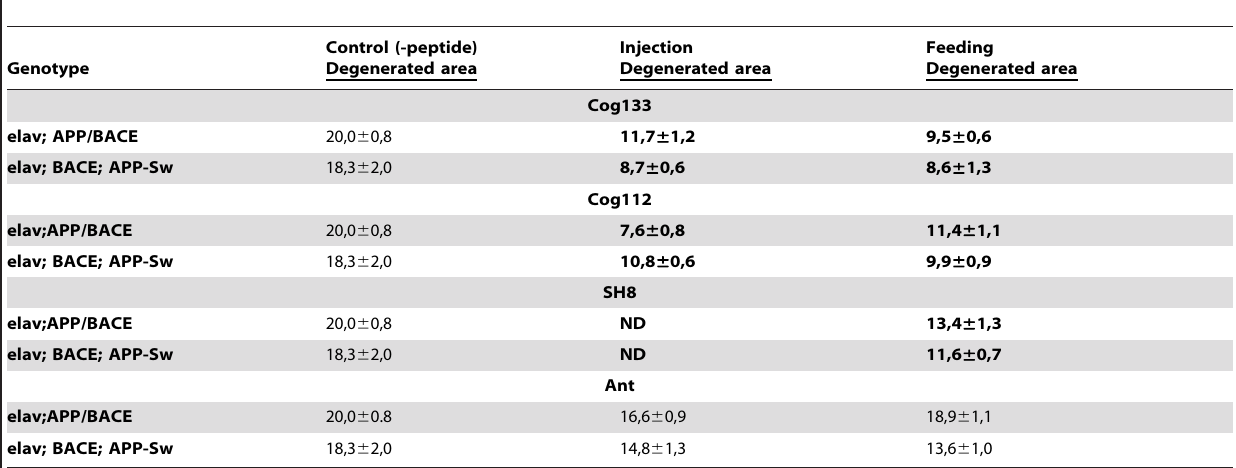
Table 4. Comparison of prevention of neurodegeneration in the brain of APP -transgenic flies by apoE-mimetics after injection and